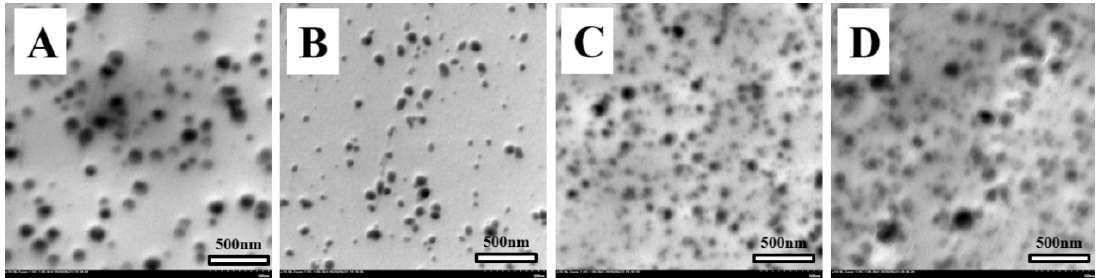
Figure 5. TEM images of PVDF / PLLA / MG02(5 / 95 / 3) upon mixing for 10 min ( A ), 20 min ( B ), 30 min ( C ) and 40 min ( D ).